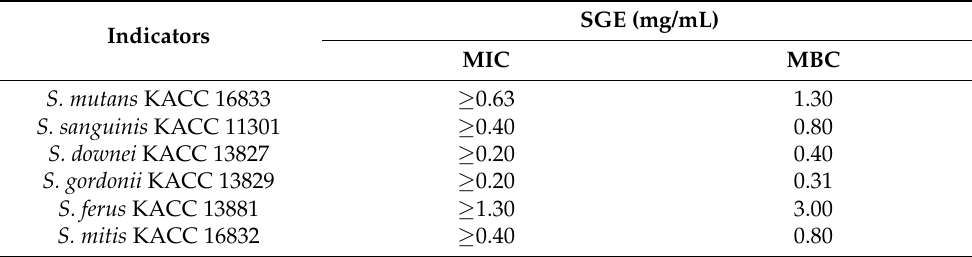
Table 3. MIC and MBC analysis of SGE against oral Streptococci